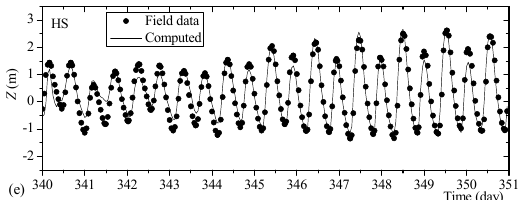
Figure 4. Comparisons of the simulated tide-level histories and field data. ( a ) at Station Xuliujing (XLJ), ( b ) at Station Qinglonggang (QLG), ( c ) at Station Lianxingang (LZG), ( d ) at Station Nanmen (NM), ( e ) at Station Hengsha (HS).